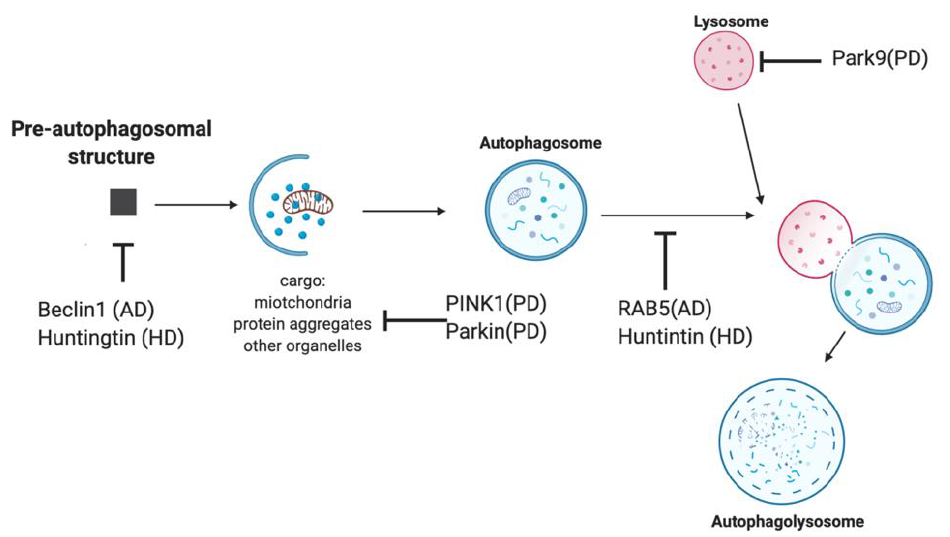
Figure 4. Autophagy mechanism and associated gene dysfunctions. Autophagy is a cellular mechanism by which metabolites, organelles, proteins and protein aggregates are enveloped by a vesicular membrane to form an autophagosome. This autophagosome is trafficked to a lysosome where fusion occurs, and lysosomal degradative enzymes break down the cargo. Dysfunction in several genes associated with neurodegenerative diseases has been implicated and are known to disrupt autophagy. The schematic image (Figure 4) was created using BioRender.com.